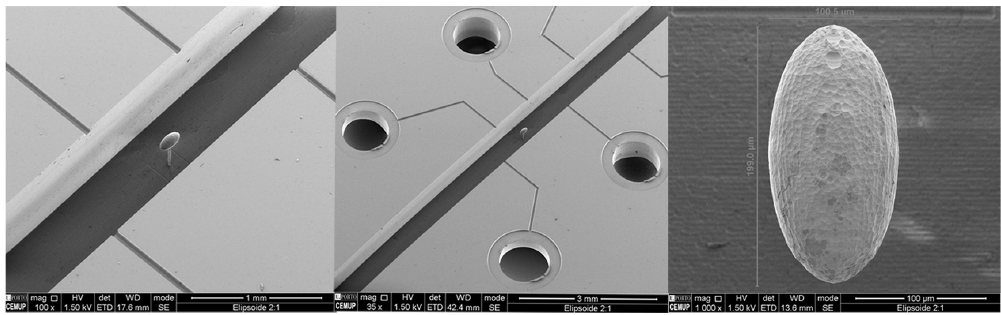
Figure 3. Scanning Electron Microscopy images of a simplified 3D microbot prototype in a microchannel.